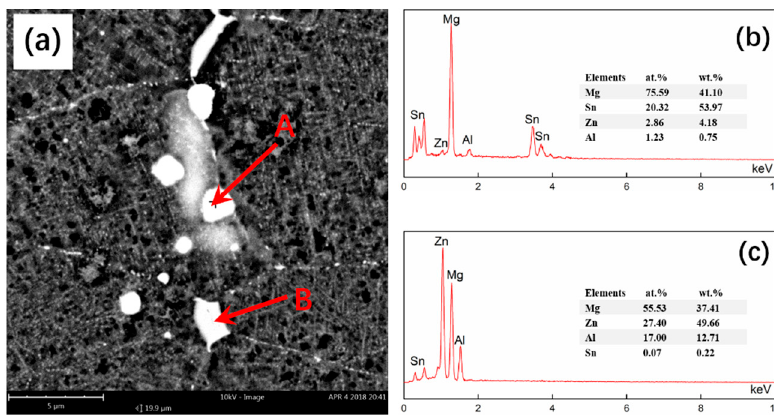
Figure 11. SEM image and EDS results of the aged ZAT642 alloy. ( a ) SEM microstructure, and ( b,c ) EDS spectrums detected from the points A and B in ( a ).